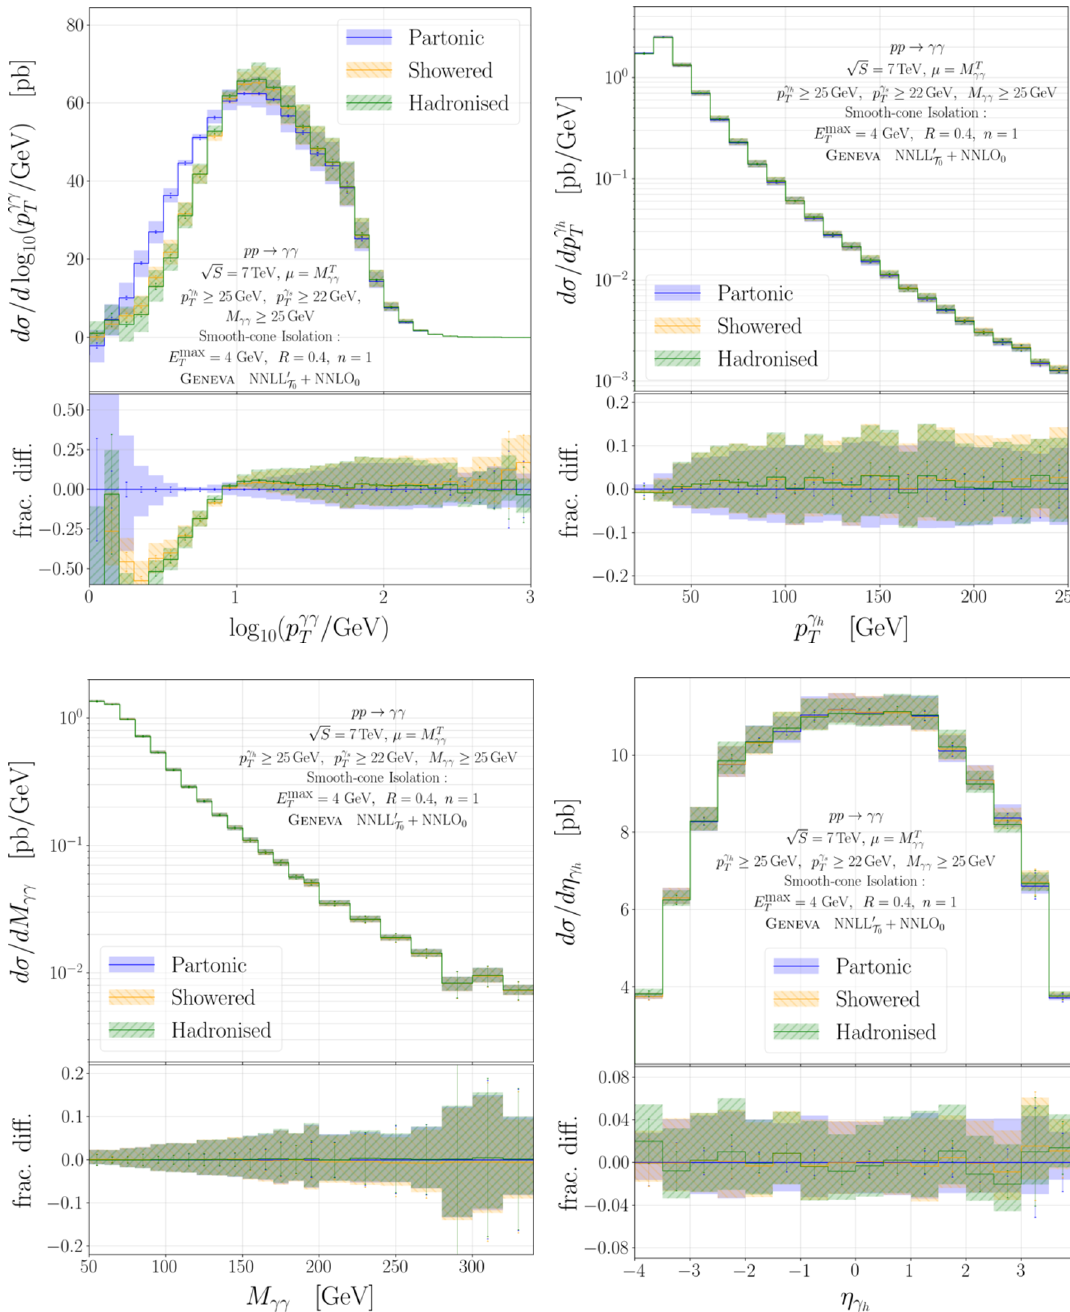
Figure 8 . Comparisons of the partonic, showered and hadronised results for a selected set of dis-